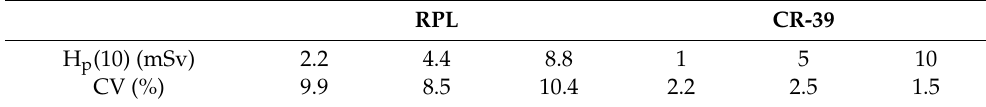
Table 1. Reproducibility of measured values of RPL and CR-39 detectors for fast neutrons. RPL CR-39